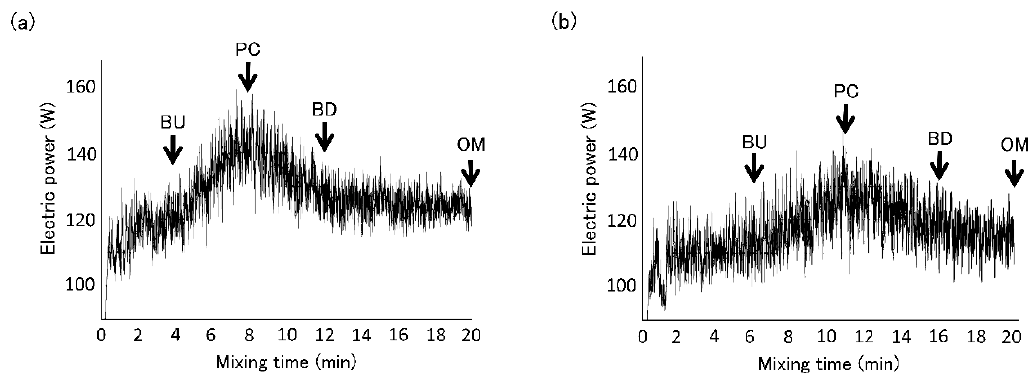
Figure 1. Dough mixing curves using high protein flour ( a , HF) and low protein flour ( b , LF). Arrows indicate sampling points. BU, PC, BD, and OM indicate build up, peak consistency, breakdown, and overmixing, respectively.